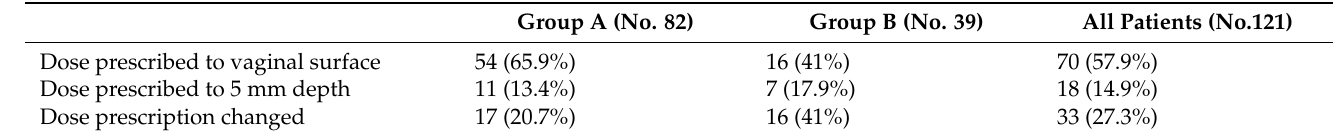
Table 2. Brachytherapy dose prescription among treatment groups.